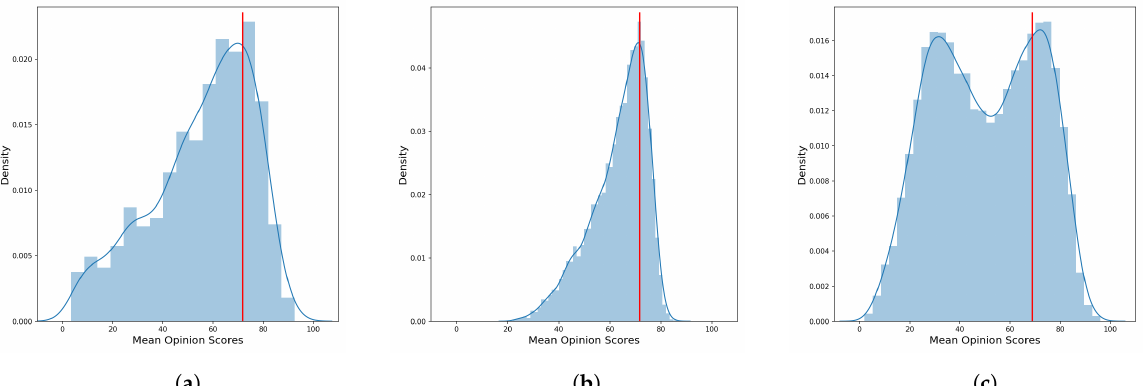
Figure 5. Estimated density distribution of Mean Opinion Scores for the three datasets: ( a ) LIVE in the Wild Image Quality Challenge Database (LIVE-itW), ( b ) KonIQ-10k (KONIQ), and ( c ) Smartphone Photography Attribute and Quality database (SPAQ). The bars represents the normalized histogram, the blue line is the estimated density distribution while in red line is the 75th percentile respect the Mean Opinion Score (MOS).